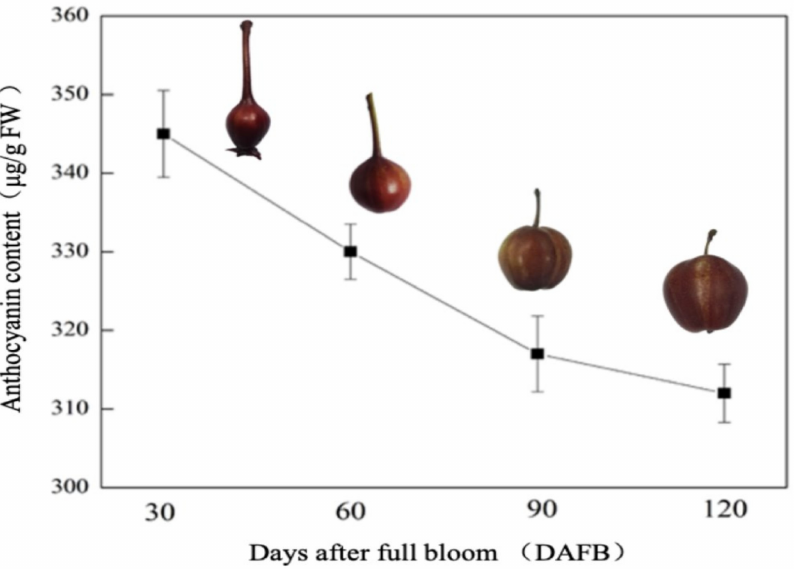
Figure 3. Anthocyanin content of ‘Red Zaosu’ at different fruit development stages. Fruits were harvested 30, 60, 90 and 120 days after full bloom